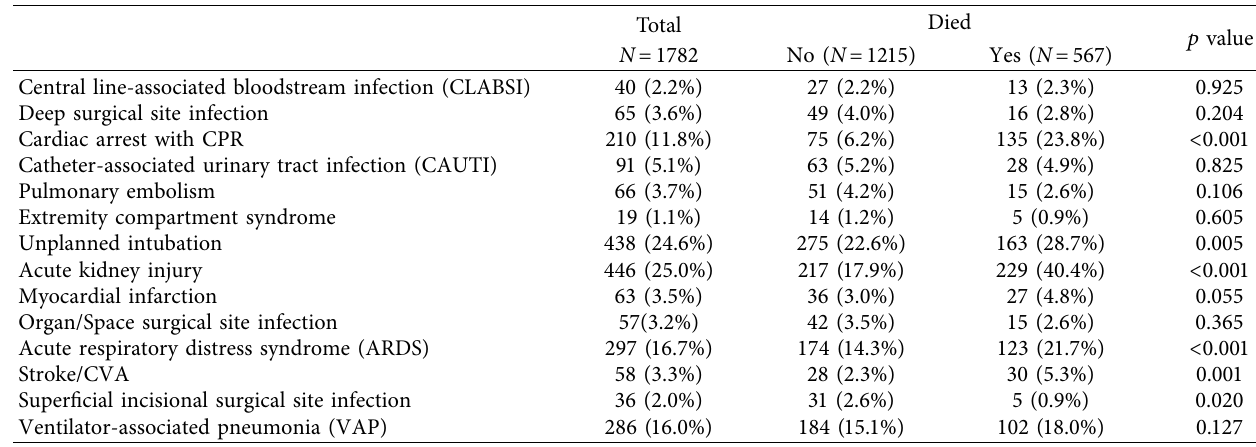
Table 4: Table showing the hospital complications experienced by the trauma patients who developed sepsis during their hospital stay.